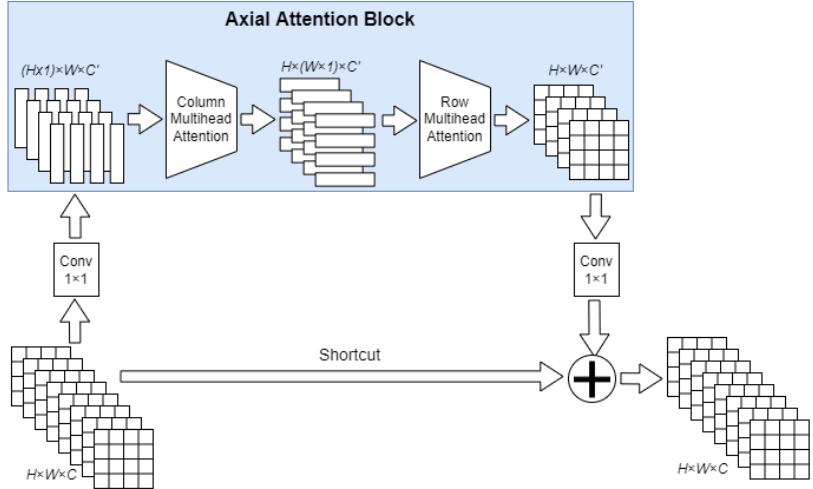
Figure 9. Residual Unit with Axial-attention